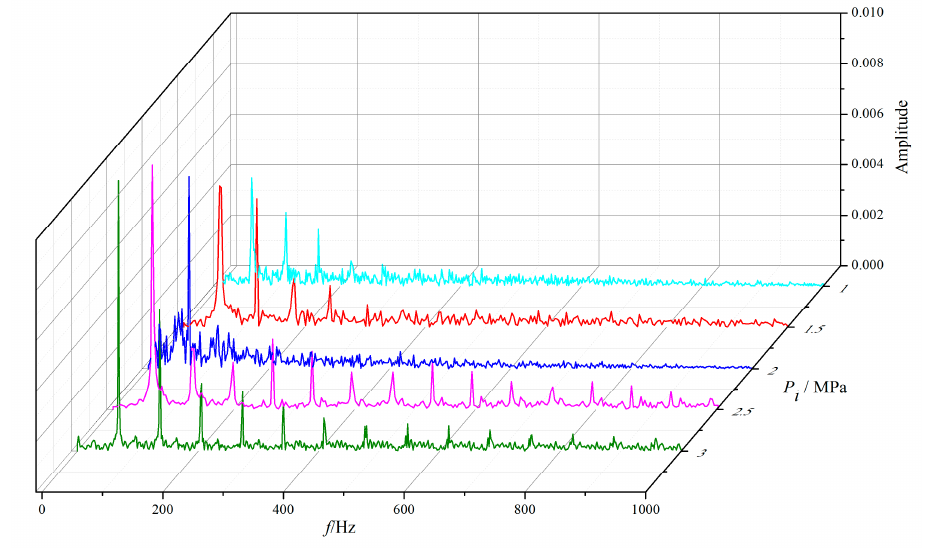
ff erent operating